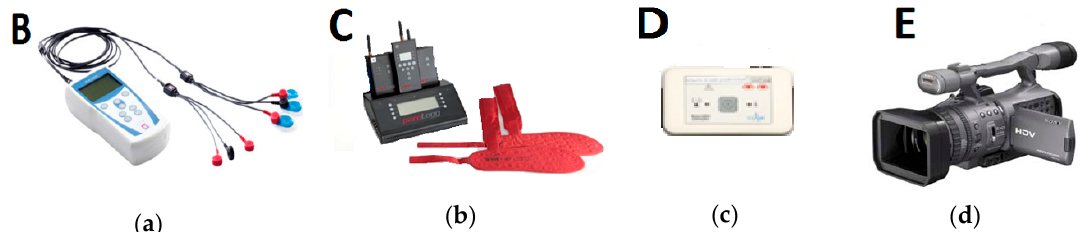
Figure 1. Motion signals measurement devices: ( a ) sensor B—a wireless (WLAN) EMG biopotentials amplifier ME6000 (Mega Electronics) with MegaWin software; ( b ) sensor C—a wireless foot pressure measurement system ParoLogg with Parologg software; ( c ) sensor D—ACC Revitus module with a